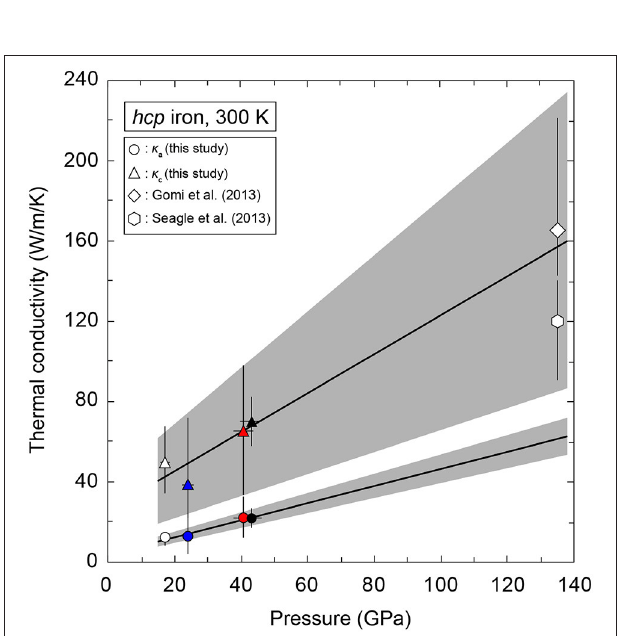
FIGURE 12 | Linear extrapolation of the obtained κ a and κ c at 300K. Values of κ el of hcp iron at 135 GPa and 300K are also plotted that were estimated from the resistivity of hcp iron ( Gomi et al., 2013) and the WF law with L 0 (open diamond), and from the hcp iron resistivity ( Seagle et al., 2013) and the WF law with L = 1.9 × 10 − 8 W (cid:127) /K 2 (open hexagon).